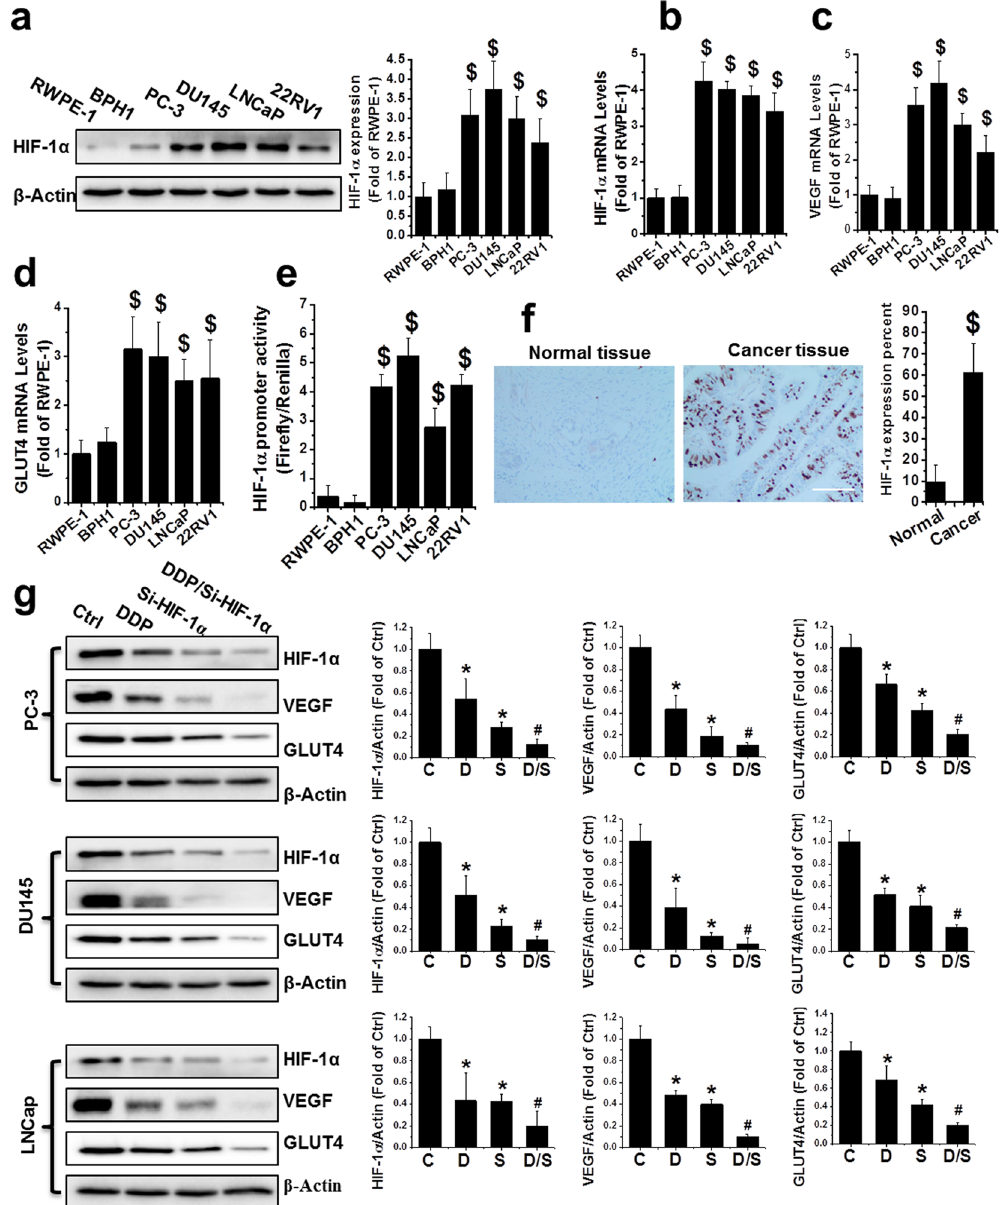
Figure 1. Upregulation of HIF-1 α in human PCa. ( a ) HIF-1 α protein was detected by western blot in nonmalignant (RWPE-1 and BPH1) and PCa cell lines (PC-3, DU145, LNCaP, and 22RV1) as indicated. ( b – d ) Total RNA extracted from RWPE-1, BPH1, PC-3, DU145, LNCaP, and 22RV1 cells was subjected to qRT-PCR for HIF-1 α ( b ), VEGF ( c ) and GLUT4 ( d ). ( e ) The HIF-1 α promoter-driven reporter (firefly luciferase) and a control vector (Renilla luciferase) were co-transfected into RWPE-1, BPH1, PC-3, DU145, LNCaP, and 22RV1 cells for measurement of luciferase activity. HIF-1 α promoter activity was calculated as a ratio of firefly to Renilla activity. ( f ) Human normal and malignant tissue (Gleason score 9) sections were probed with HIF-1 α antibody (scale bars, 100 µ m). ( g ) Protein expression of HIF-1 α , VEGF, and GLUT4 were examined with western blot, in PC-3, DU145, and LNCaP cells after various treatments as indicated. Data are expressed as mean ± SD of seven independent experiments. $ p < 0.05 versus RWPE-1 or BPH1 cells or normal tissue. * p < 0.05 versus control group. # p < 0.05 versus si-HIF-1 α or DDP group. Original blots are shown in Supplementary Figure 5. C: Ctrl; D: DDP; S: si-HIF-1 α ; D/S: DDP/si-HIF-1 α